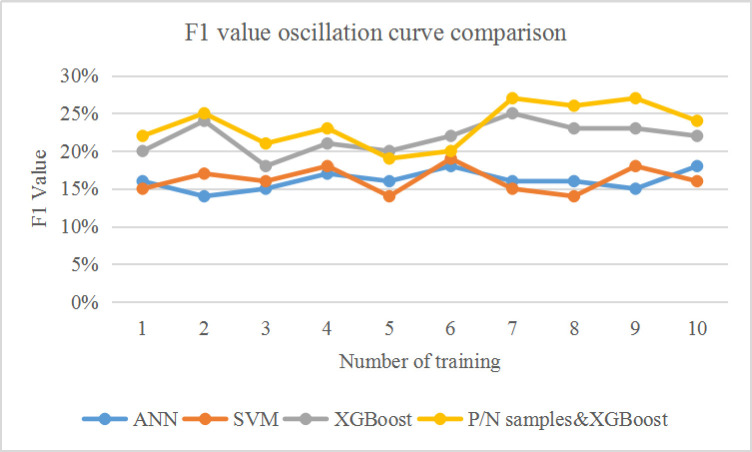
Comparison of different models of F1 oscillation curve.